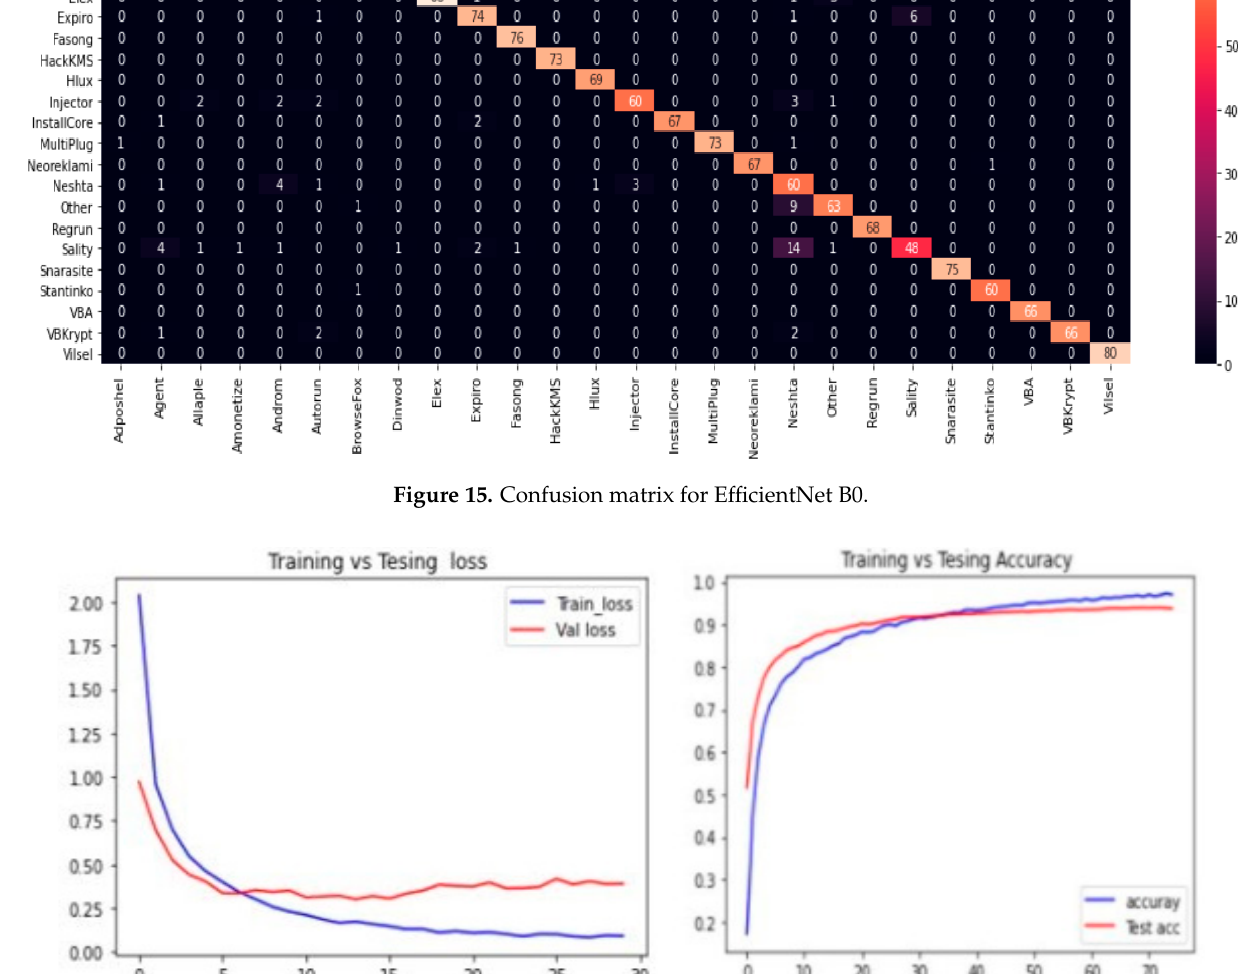
Figure 16. Training and training loss of EfficientNet B0.